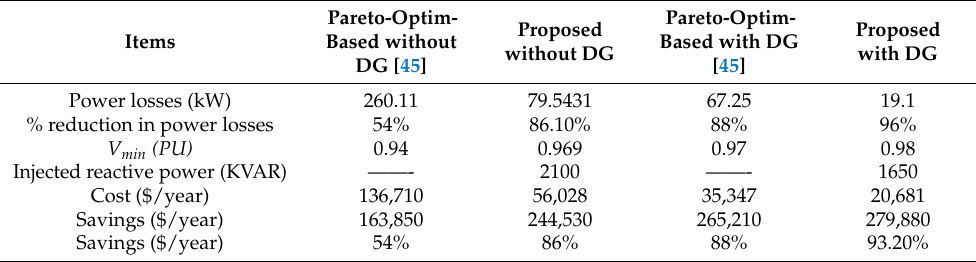
Table 12. Unbalanced IEEE 123 system performance with different